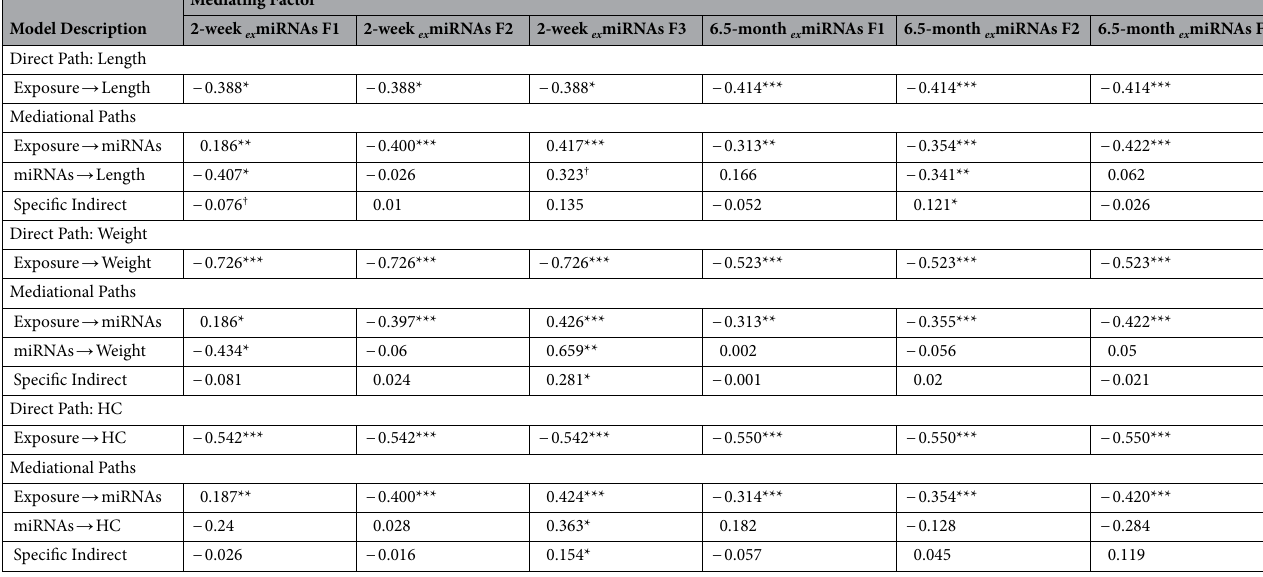
Table 4. Models assessing mediation by ex miRNAs of the effects of prenatal alcohol exposure on postnatal infant growth, controlling for smoking. Mediational models predicting growth from alcohol exposure (direct effect) and through miRNAs (mediating variables). The effects of alcohol exposure on growth are adjusted for level of maternal smoking during pregnancy. Estimates are standardized regression coefficients for the direct paths and for each of the indirect paths. Direct path = effect of PAE on the growth measure; mediational paths = effects of PAE on ex miRNA expression level and effects of ex miRNA expression level on the growth measure; specific indirect = the degree to which the effect of PAE was mediated by the expression levels of the ex miRNAs in each factor. Estimates for the specific indirect paths are the product of the regression coefficients for the two indirect paths. HC = head circumference; Exposure = prenatal alcohol exposure (AA/day); 2-week ex miRNAs F1 = cell maturation, cell cycle inhibition, and somatic growth; 2-week ex miRNAs F2 = cell survival, apoptosis, cardiac development, and metabolism; 2-week ex miRNAs F3 = cell proliferation, skeletal development, hematopoiesis, and inflammation; 6.5-Month ex miRNAs F1 = neurodevelopment, neural crest/ mesoderm-derivative development, and growth; 6.5-Month ex miRNAs F2 = immune system and